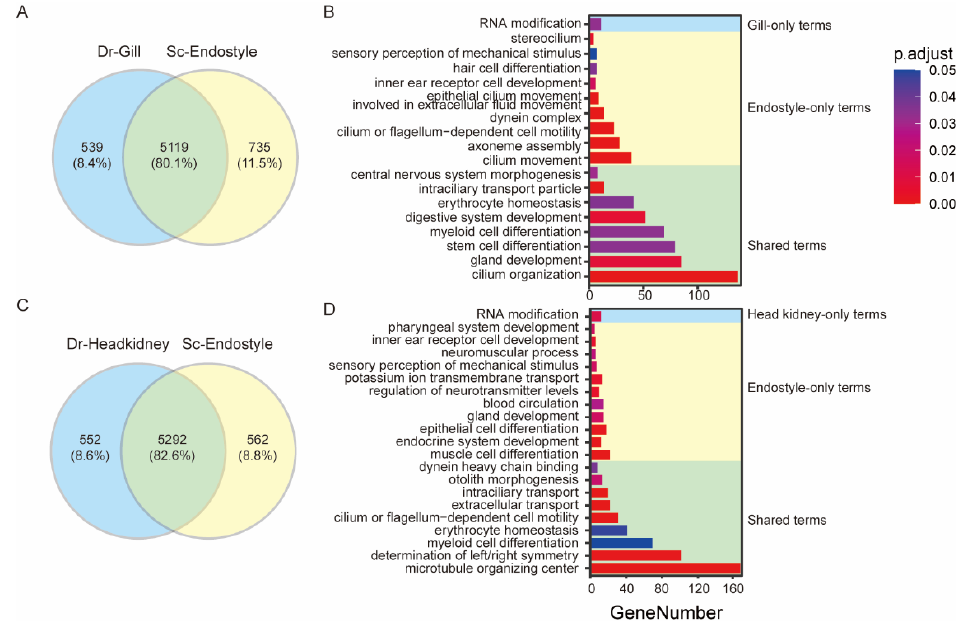
Figure 4. Expression profile comparison between endostyle and potentially similar organs. ( A , C ) Venn diagrams are patronizing the shared and unique expressed genes between the endostyle and the Danio gill and the Danio head kidney, respectively. ( B , D ) GO enrichment analysis for shared or organ specifically expressed gene lists in ( A , C ).